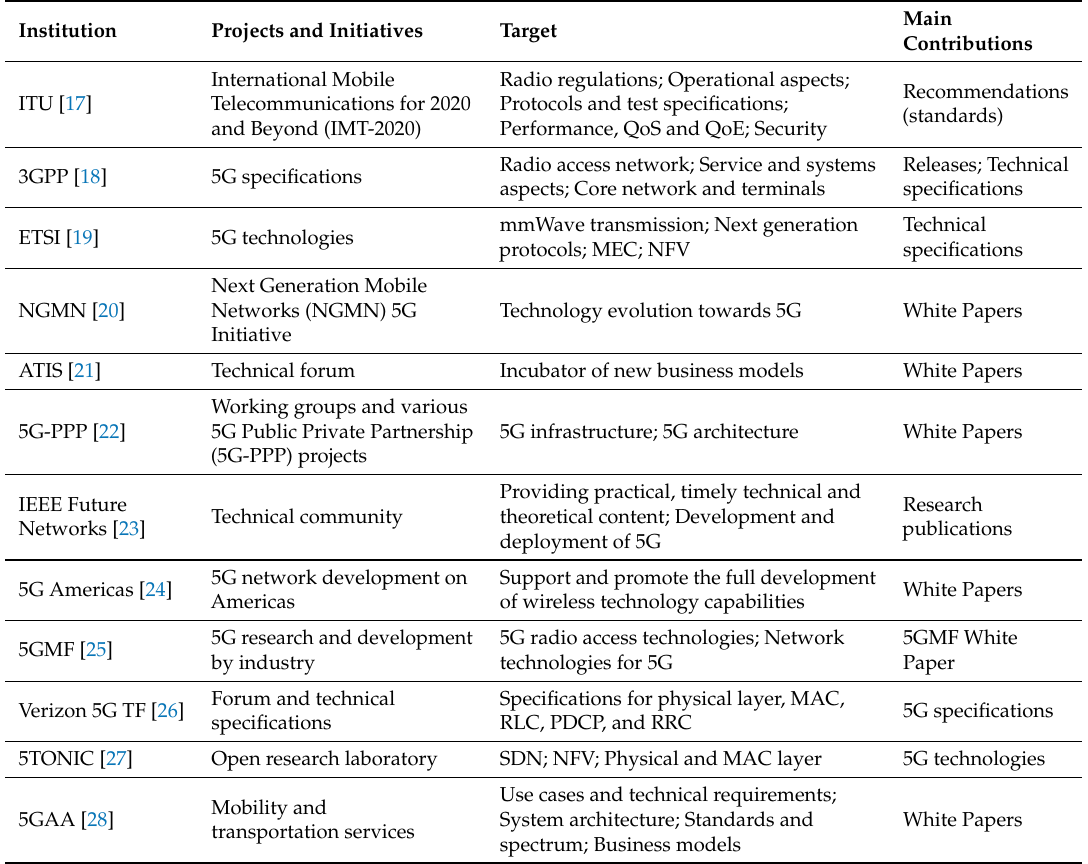
Table 1. Panorama of 5G networks development and